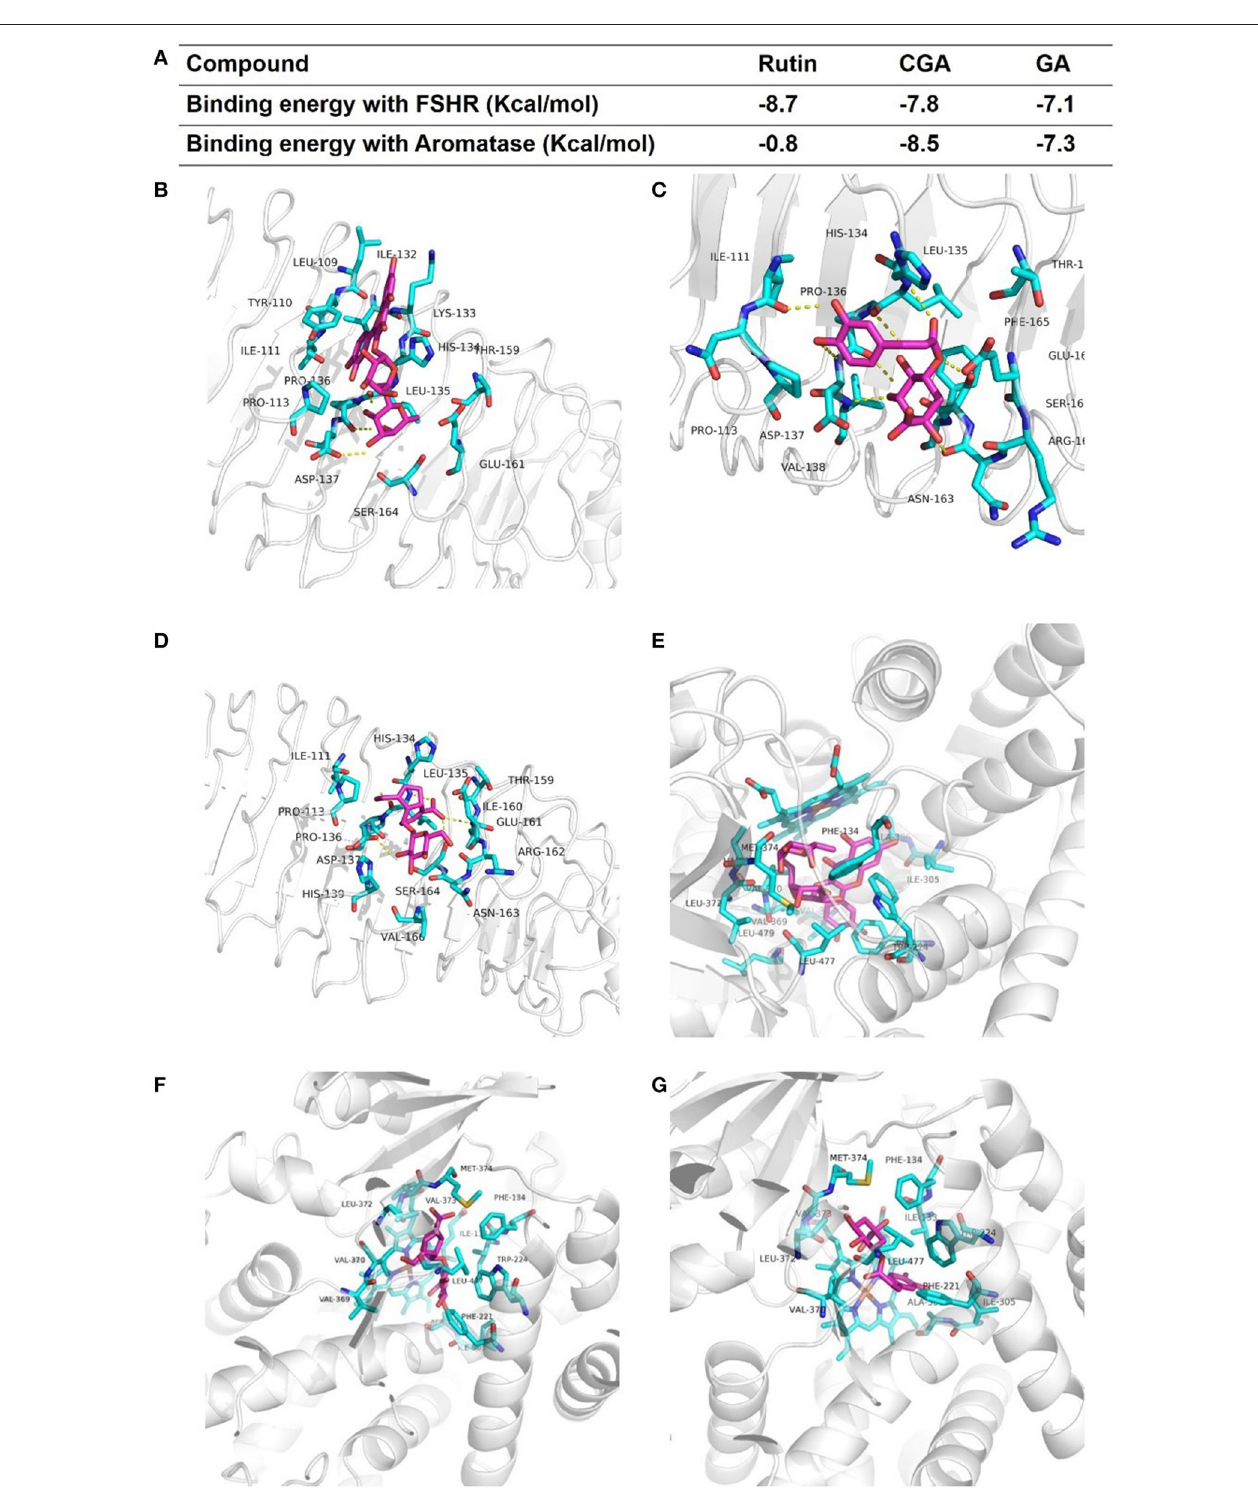
FIGURE 10 | Modes of binding of rutin, CGA and GA with FSHR and aromatase. (A) The binding energy of each complex. (B–D) The optimal binding conformations of the FSHR-rutin complexes, FSHR-CGA complexes and FSHR-GA complexes. (E–G) The optimal binding conformations of the aromatase-rutin complexes, aromatase-CGA complexes and aromatase-GA